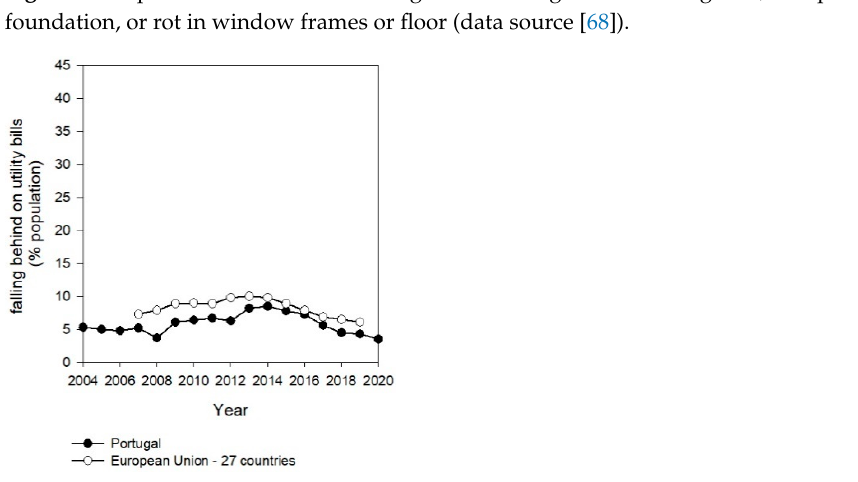
Figure 7. Share of the total population falling behind on utility bills (data source [70]).